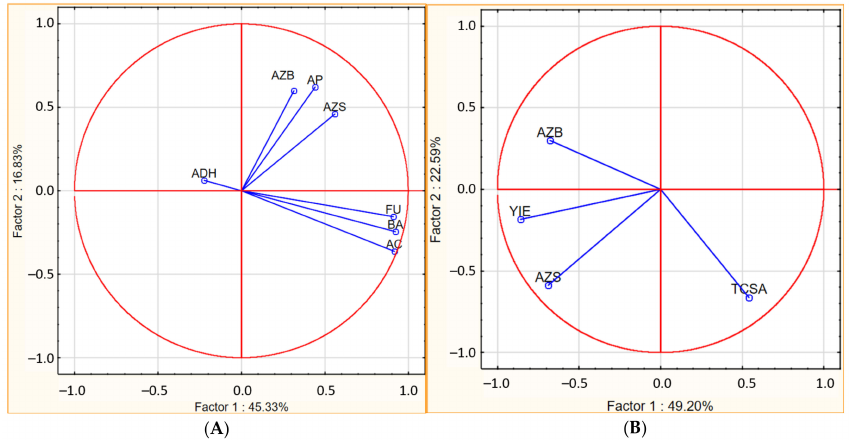
Figure 11. ( A )—enzymatic activity dehydrogenases and proteases on the abundance of soil mi- croorganisms, ( B )—the effect of diazotrophic bacteria on yield and growth. ADH—dehydrogenases, AP—proteases, AZB— Azotobacter , AZS— Azospirillum , FU—fungi, BA—bacteria, AC—actinobacteria, YIE—yield kg/tree, TCSA—cross-sectional area of the trunk.